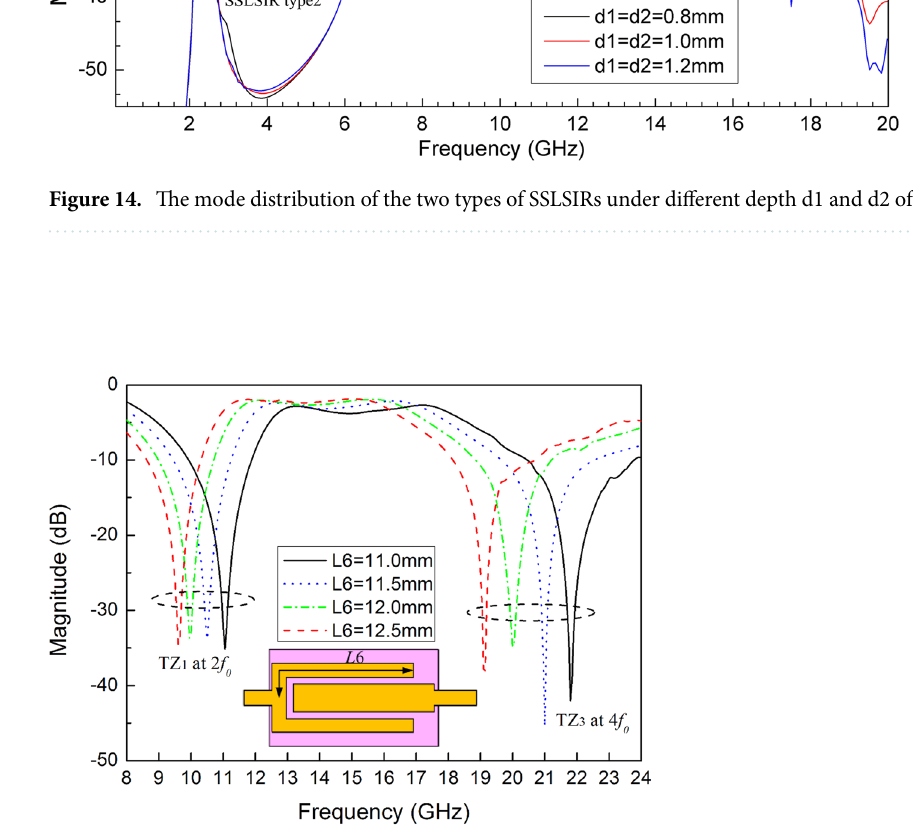
Figure 15. Variable TZ1 and TZ3 corresponding to different length